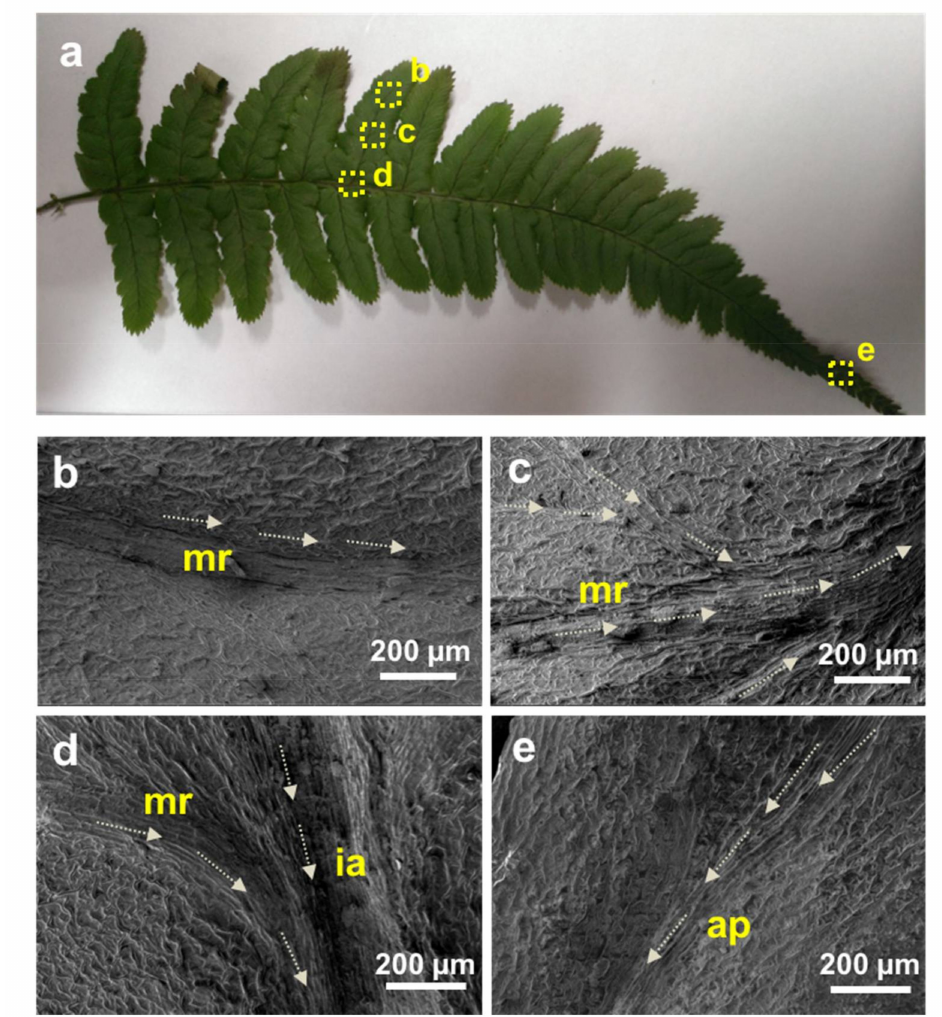
Figure 6. (a) Photograph of the D. marginata frond with labeled areas showing different locations of the water channels. ( b – e ) Scanning electron microscopy micrographs of the labeled areas in ( a ); arrows indicate the presumed direction of the water transport through these channels. ap: apex; ia: inner axis; mr: